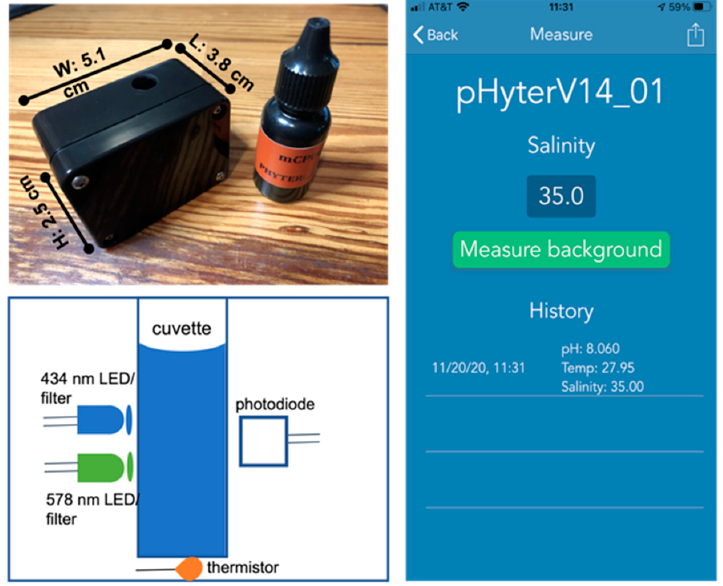
Figure 1. (The pHyter). The pHyter next to an mCP reagent bottle ( upper left ); pHyter optical design ( lower left ); and pHyter phone app ( right ). ( lower left ); and pHyter phone app ( right